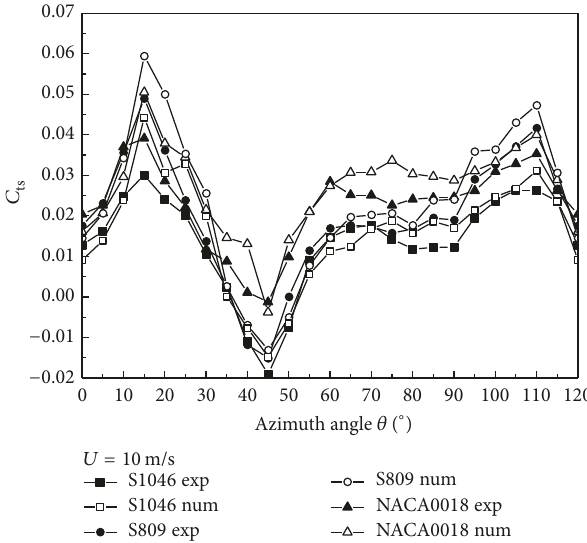
Figure 14: Static torque coefficients ( 𝑈 = 10